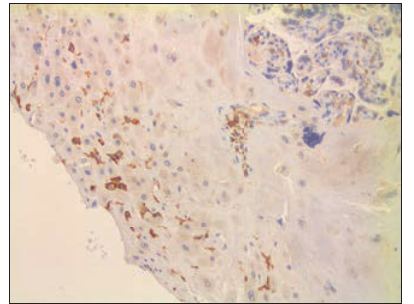
Fig. 3. DC-SIGNR expression in endothelial cells and Hofbauer cells in an HIV-positive case with maternal CD4 + count of 365 cells/µl and a viral load of 3.84 log. (DC-SIGNR = human dendritic cell- specifi c intracellular adhesion molecule-3 (ICAM3)- grabbing non-integrin-related molecule.)